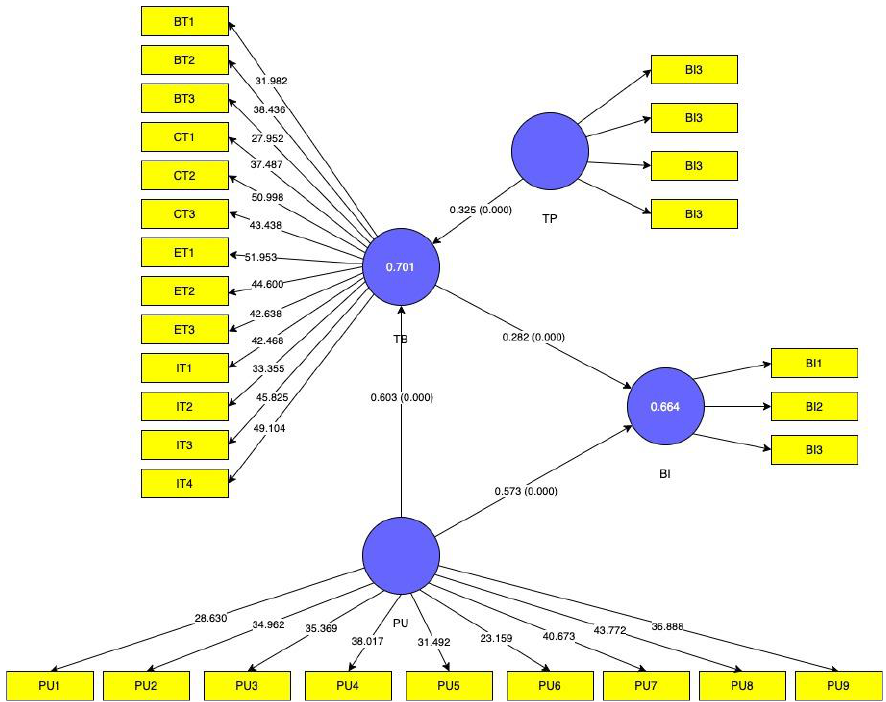
Figure 2. Result of structural model inspection (Complete sample). Note: BI: Behavioural Intentions, PU: Perceived usefulness, TB: Trusting Beliefs, TP: Trust Propensity. (0.000) indicates all direct paths are (Sig. at p <